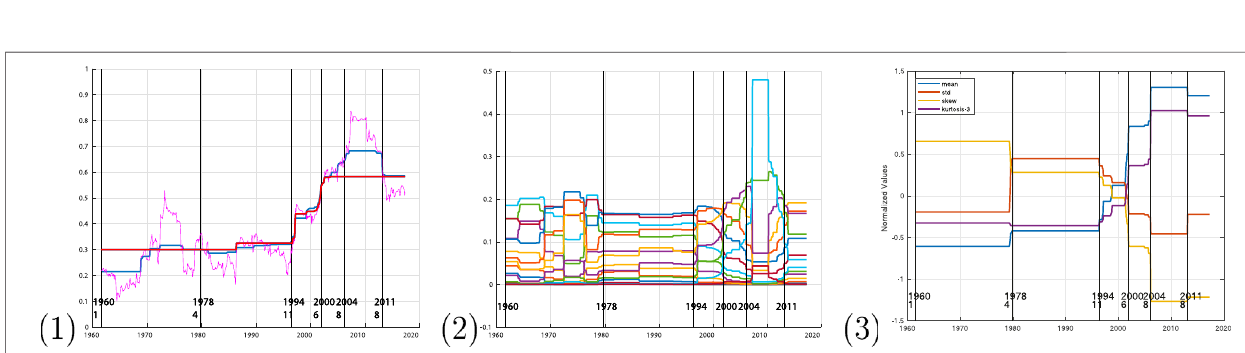
not have to choose the sampling.